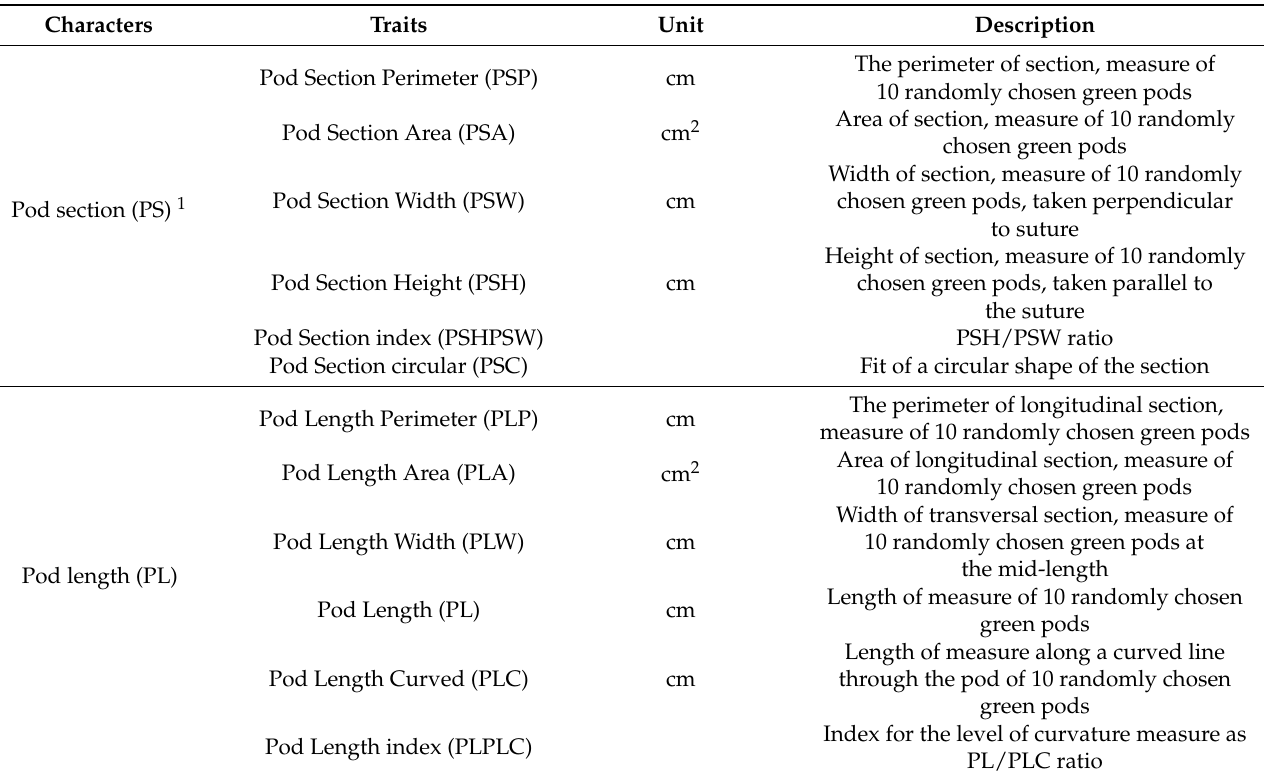
Table 1. List of the 12 pod traits analyzed using the software Tomato Analyzer. The code assigned to each character is indicated in parentheses. The green pods were collected at the beginning of the R8 stage, pods developed, and seeds